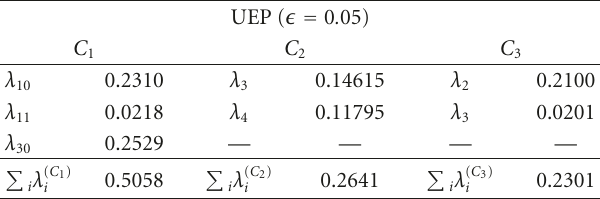
Table 2: Degree distributions for the di ff erent classes with (cid:2) = 0 . 05. R = 1 / 2.